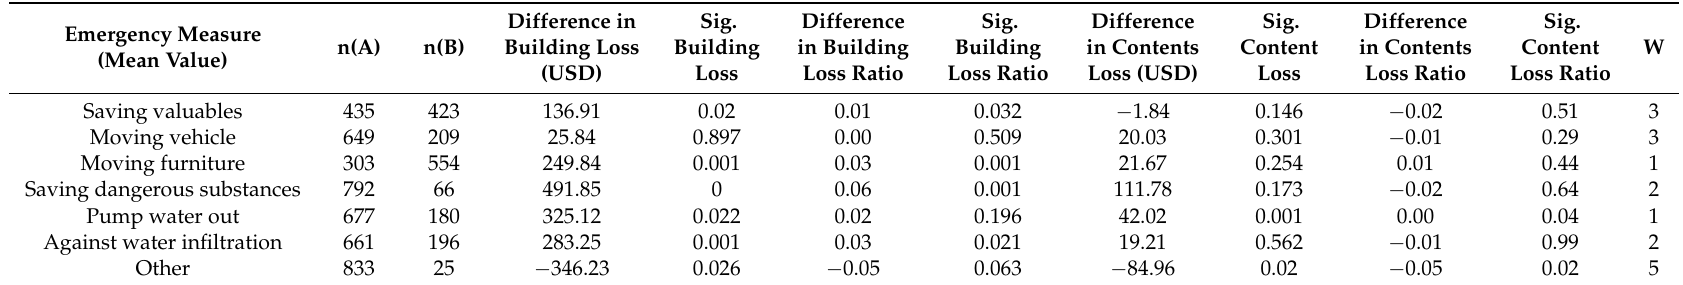
Table 5. Weight of emergency measures (n is the total number of cases; w is the weight for the indicator of the difference in losses; n(A) is the number of houses that did not apply measures; n(B) is the number of houses that applied measure; the difference in losses expresses the loss reduction between Group B and Group A; sig. is significance probability or p -value; a positive value means that the measure has no reduction in losses; a negative value means that the measure has a reduction in losses; the significance expresses the correlation coefficient between losses and measures).